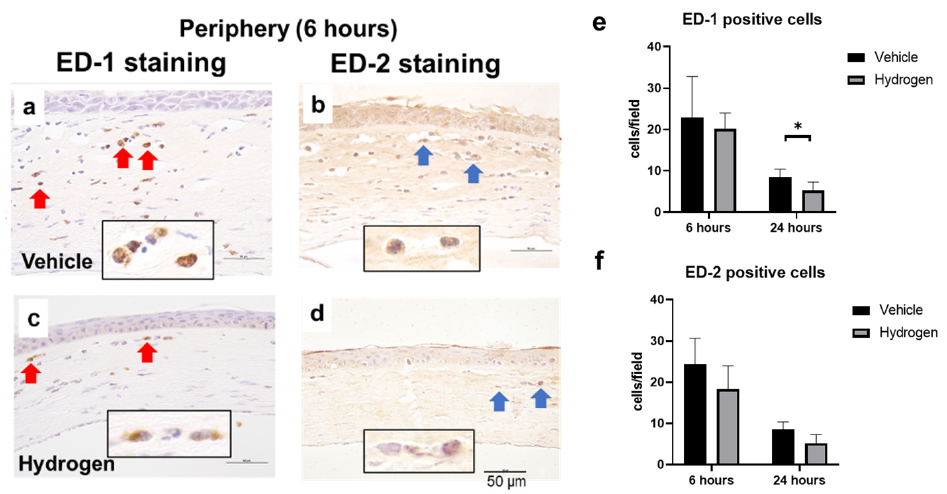
formed to evaluate neutrophil infiltration in the vehicle group ( a ) and the hydrogen group ( b ) in the corneal limbus at 6 h after injury (black arrows: EST-positive cells); 8-OHdG staining was also per- formed in the vehicle group (( d ): 6 h, ( e ): 24 h) and in the hydrogen group (( f ): 6 h, ( g ): 24 h) in the corneal limbus. Bar, 50 μ m. The number of EST-positive neutrophils at 6 h after injury was lower in the hydrogen group than in the vehicle group ( c ). * p < 0.05. Data are presented as the mean ± stand- ard error ( n = 5 per group).